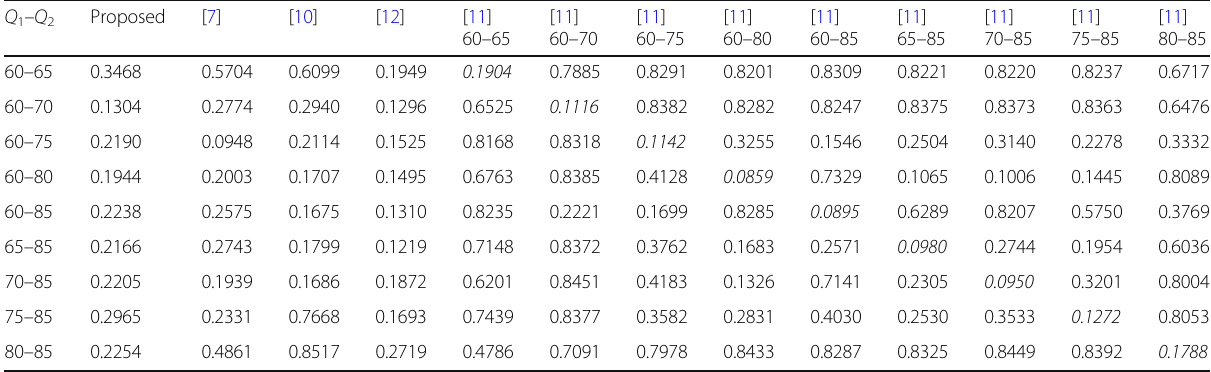
Table 1 Misclassification error rate for randomly tampered images Q 1 – Q 2